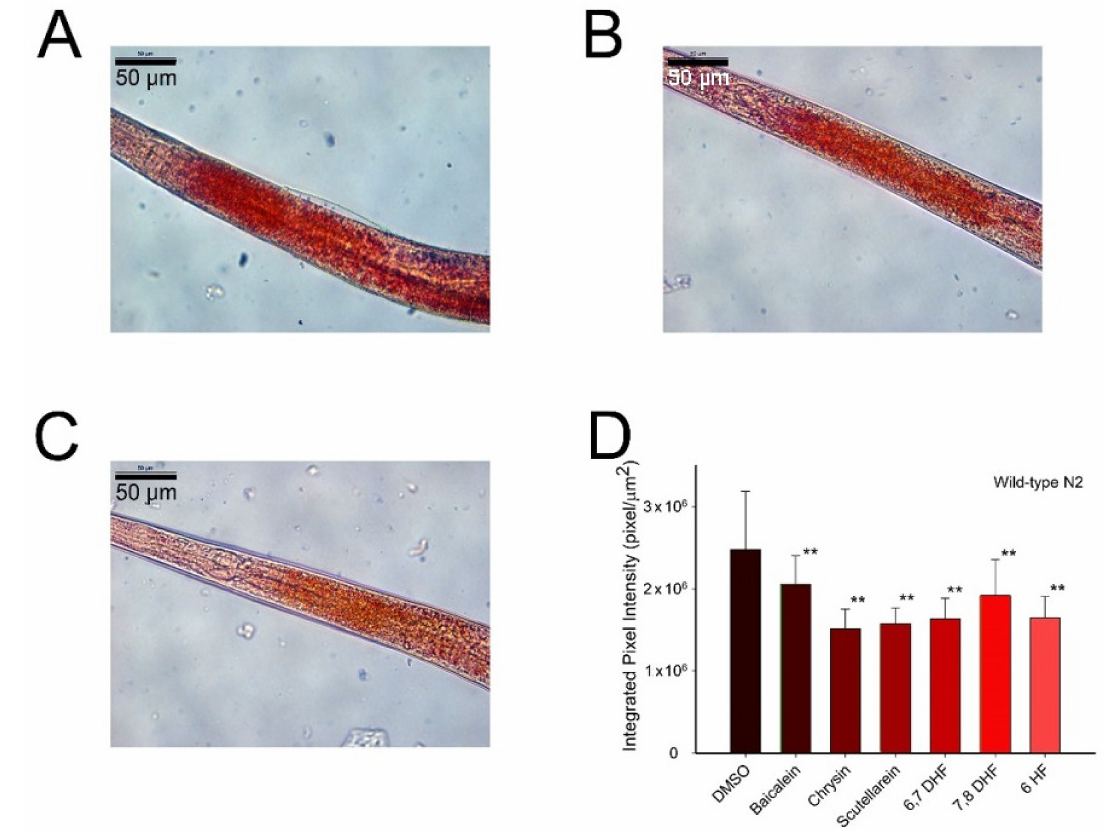
Figure 3. Effects of flavonoids on fat accumulation in C. elegans measured with Oil Red O (ORO). ( A ) DMSO control worms. ( B ) Worm treated with 100 µ M of scutellarein. ( C ) Worm treated with 100 µ M of chrysin. ( D ) Lipid content measurement with ORO staining in C. elegans treated with 100 µ M of each flavonoid. Data are represented as mean ± S.D, n > 10; two independent experiments were performed; ** significant at p ≤ 0.05 by ANOVA test. Scale bar: 50 µ m, magnification 40 ×